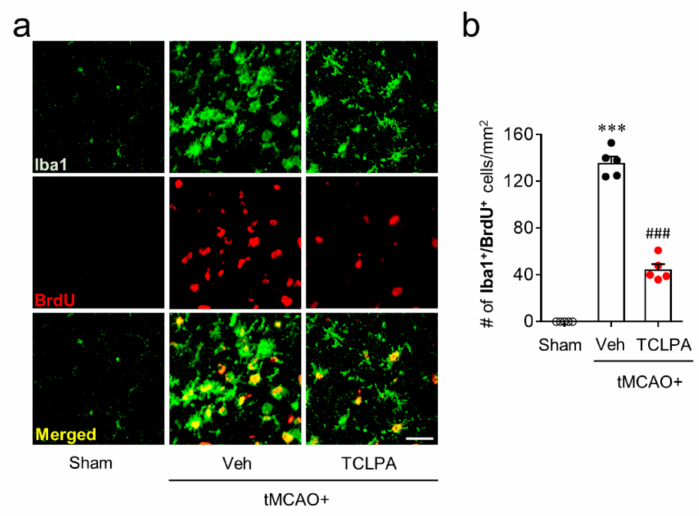
Figure 5. LPA 5 antagonism attenuates microglial proliferation in injured brain after tMCAO challenge. Mice were challenged with tMCAO. TCLPA5 (TCLPA: 10 mg / kg, i.p.) was administered immediately after reperfusion, and microglia proliferation was assessed by Iba1 / BrdU double immunofluorescence at three days after tMCAO challenge. ( a ). Representative images of Iba1 / BrdU-double immunopositive cells in the penumbra region (the area between the periischemic and ischemic regions). Scale bar, 50 µ m. ( b ) Quantification of Iba1 / BrdU-double immunopositive cells. n = 5 mice per group. *** p < 0.001 vs. sham; ### p < 0.001 vs. vehicle-administered tMCAO